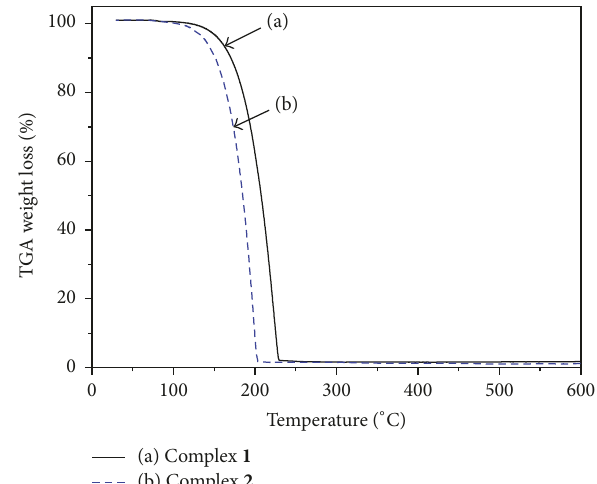
Figure 1: TGA curves of bis (2-hydroxy-1-naphthaldehydato)cadmium(II) (complex 1 ) (a) and bis (salicylidene)cadmium(II) (complex 2 ) (b).